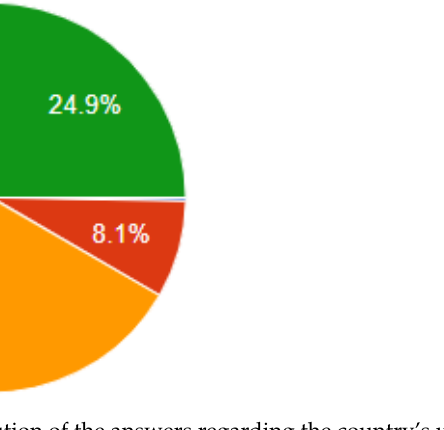
Figure 2. The distribution of the answers regarding the country’s use of RESs.